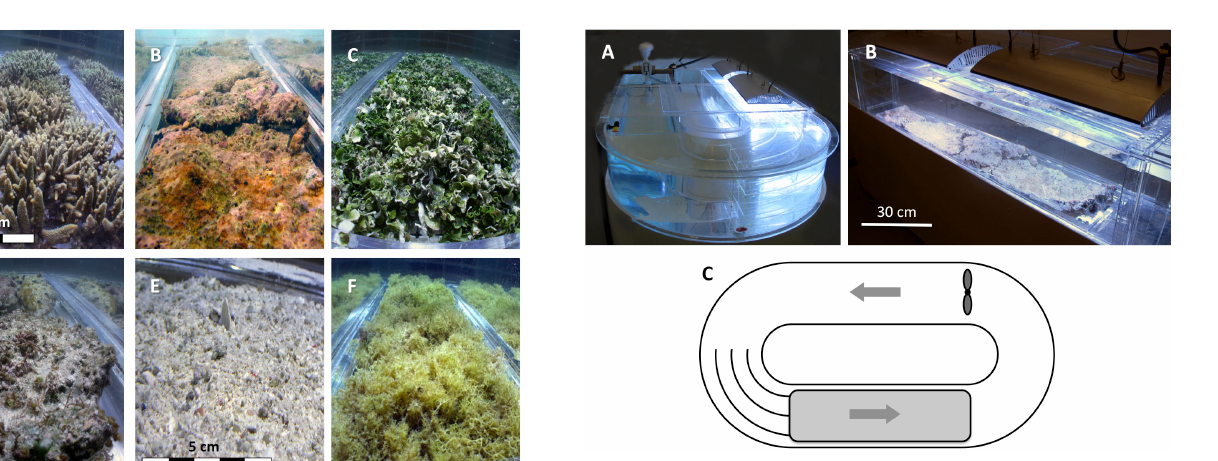
Fig. 4. Recirculating laboratory flume used for carbon flux studies of benthic reef flat communities. (A) and (B) end and side perspec- tives during run with a community of crustose coralline algae. (C) top-view diagram showing flow collimators (curved lines), flow di- rection (arrows) and position of propeller. The sunken (0.1m) work- ing section (grey area) measures 0.4m by